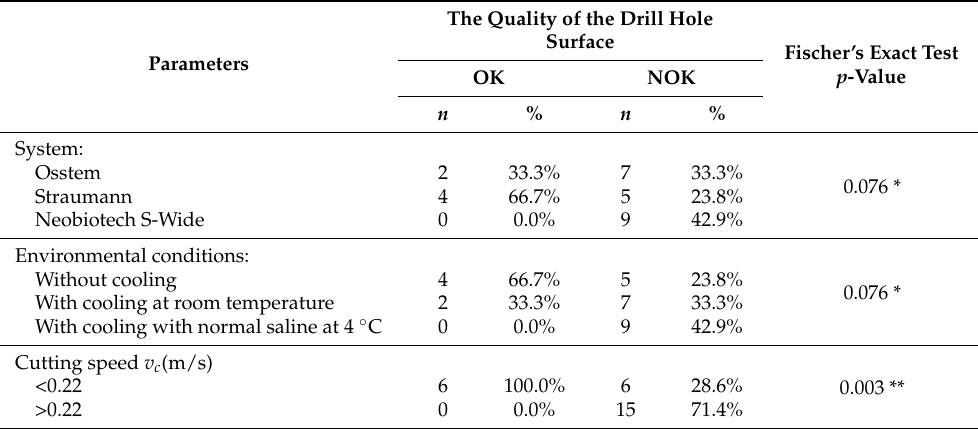
Table 2. Distribution of study preparation parameters in the groups differing in the quality of the drill hole surface.